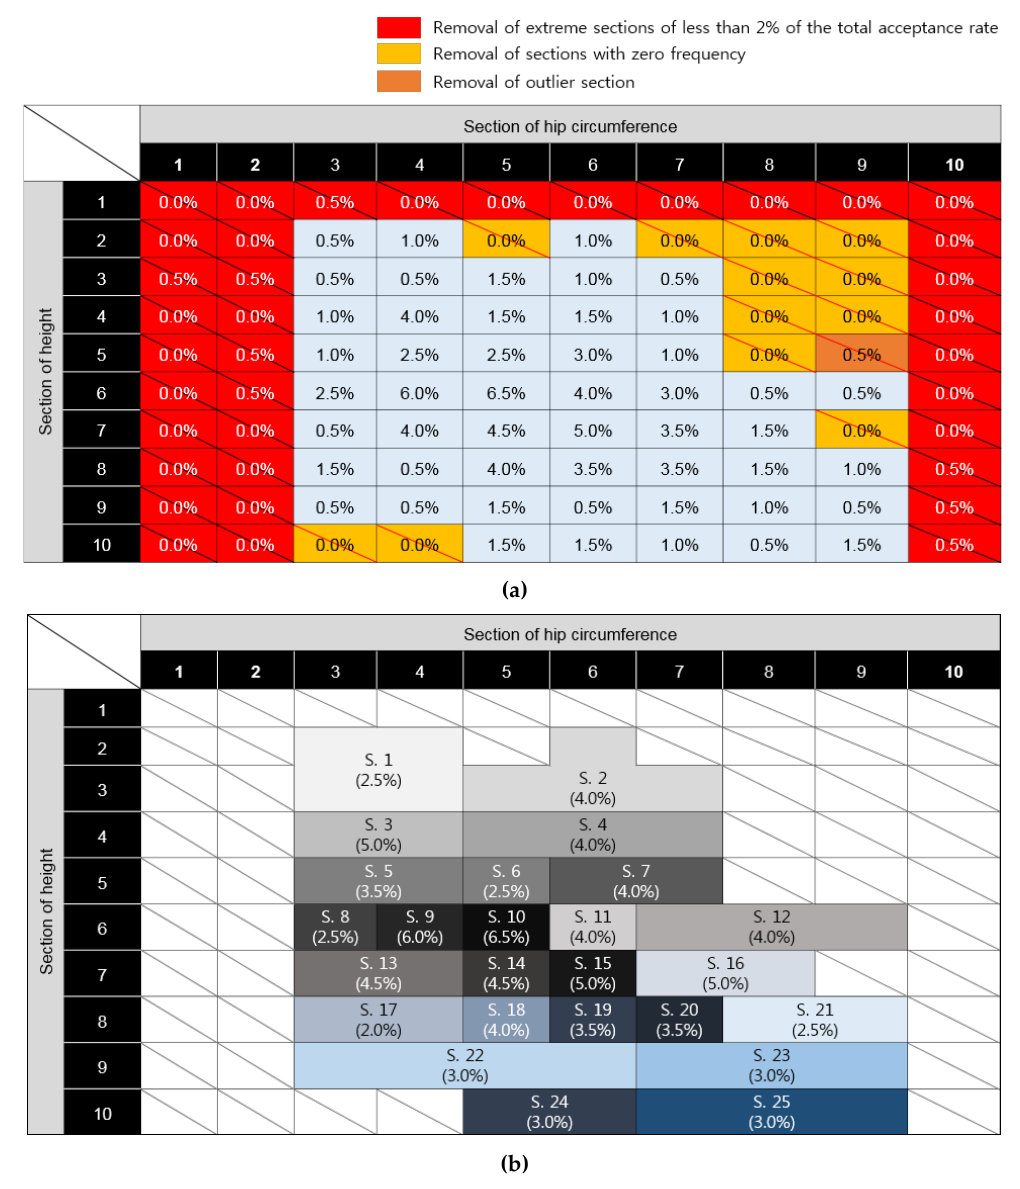
Figure 2. Section removal and grouping process of primary cross-tabulation: ( a ) section removal and ( b ) section grouping.